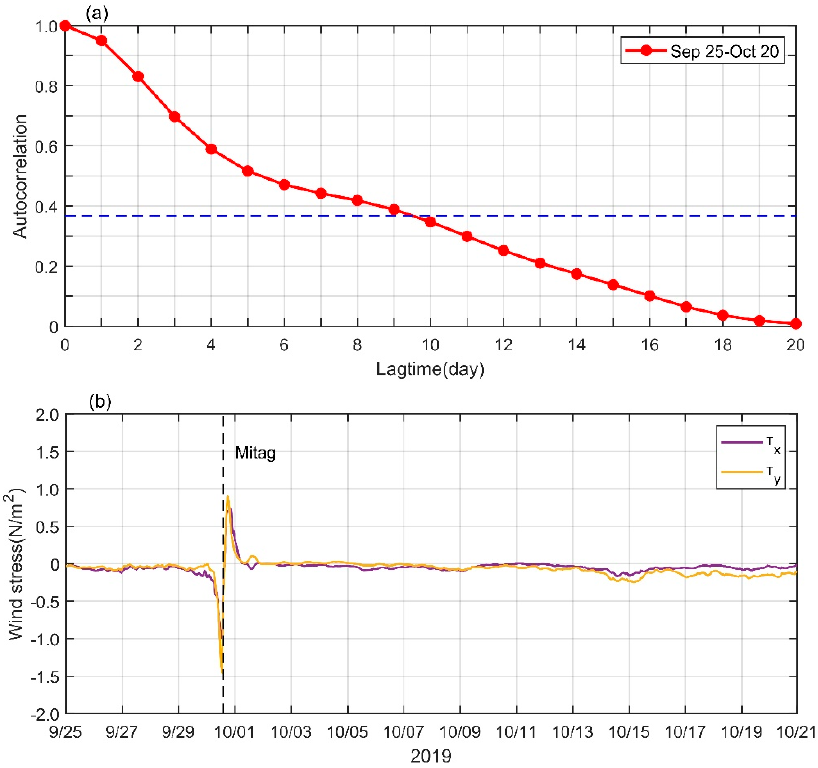
Figure 8. ( a ) Autocorrelation of the depth-averaged (from 50 to 540 m) NIKE from 25 September to 20 October 2019, and the horizontal blue dashed line denotes the value of 1/e. ( b ) Time series of the wind stress at the mooring at 10 m over the sea surface, and the purple and yellow lines represent the zonal and meridional wind stresses. The vertical black dashed line denotes the time when typhoon Mitag’s center was closest to the mooring.